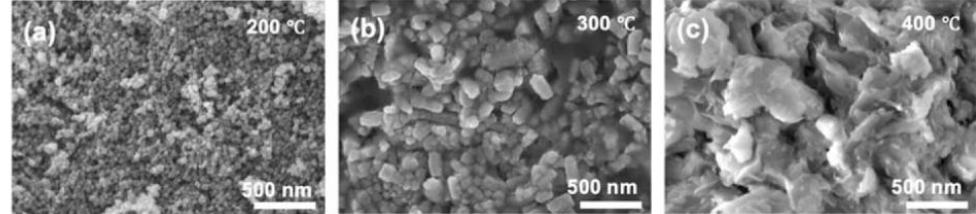
Figure 11. Particle size of zinc oxide at different calcination temperatures. ( a ) 200 ◦ C, ( b ) 300 ◦ C, ( c ) 400 ◦ C.